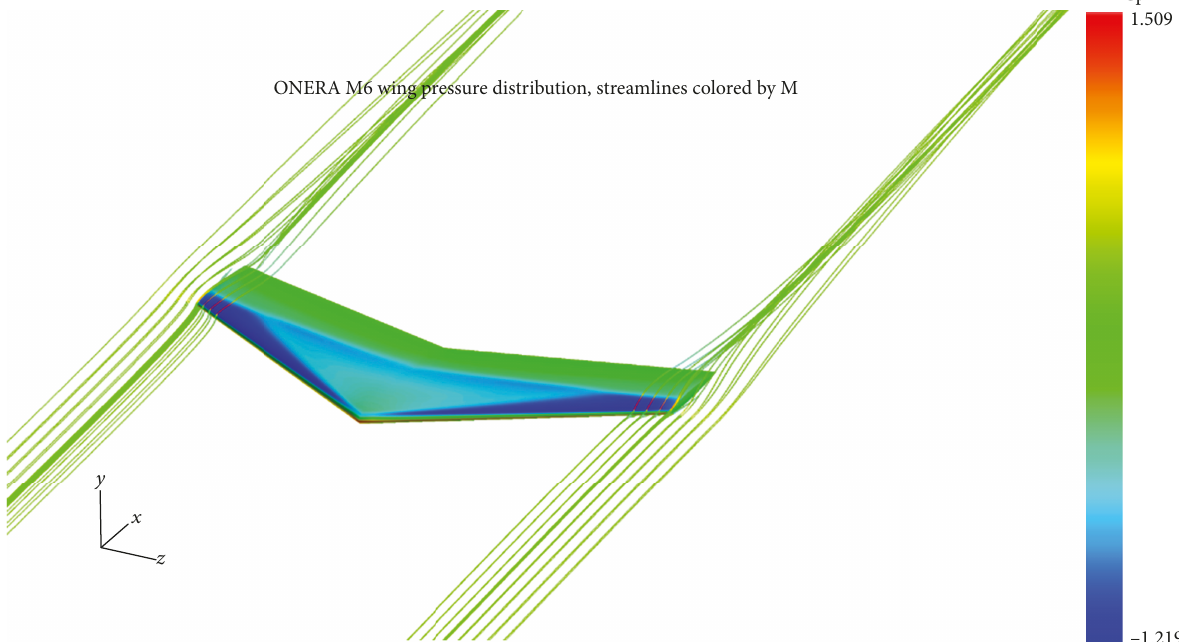
Figure 19: Plain ONERA M6 wing under SW1.